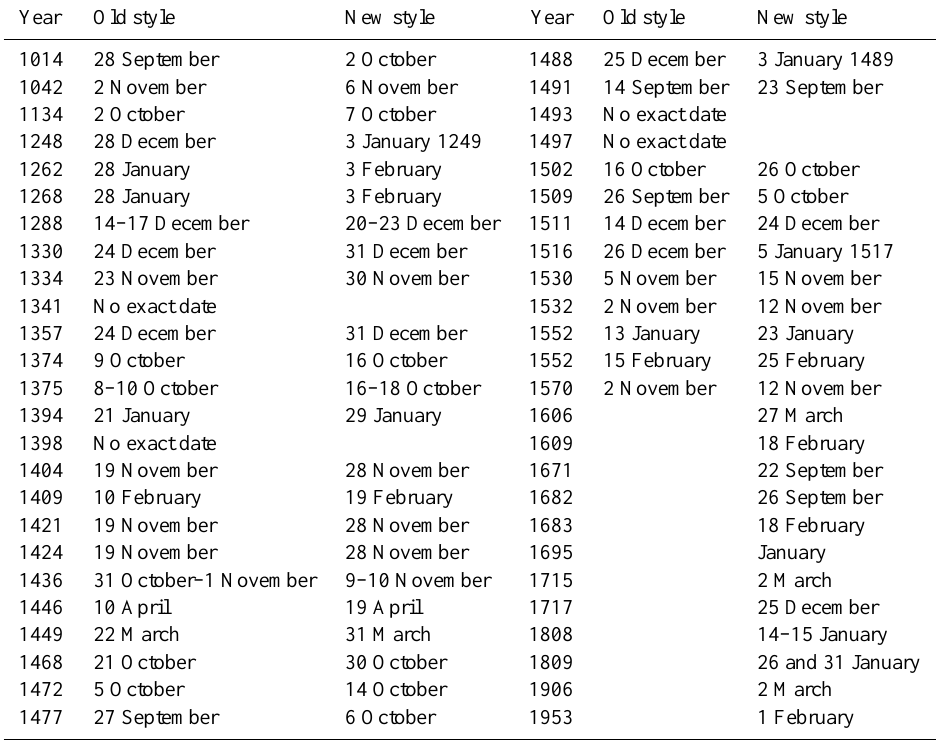
Table 1. Flooding caused by storm surges in Zeeuws-Vlaanderen and elsewhere in Zeeland,